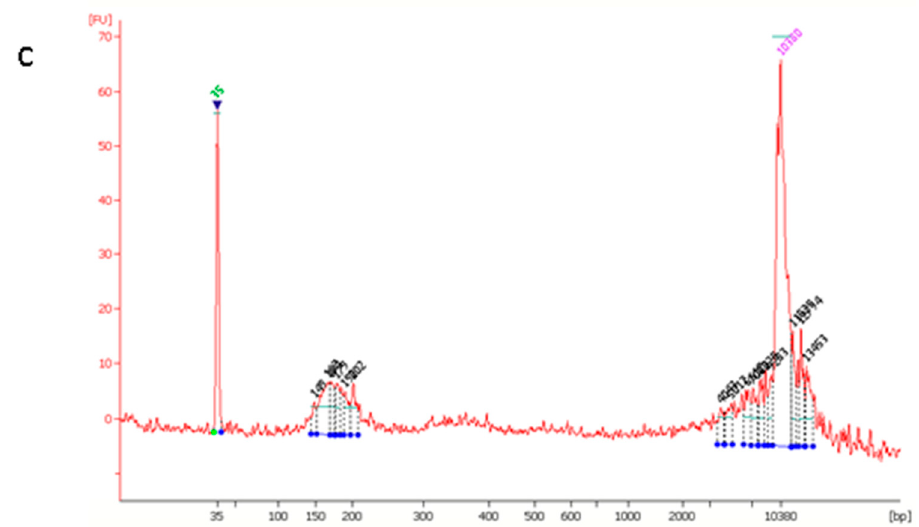
Figure 2. Electrophoregrams of pooled DNA sample from HF blood plasma NPCs ( a ) and individual DNA samples from BCP blood plasma NPCs ( b , c ). Data of Agilent 2100 Bioanalyser TM assay. Positions of 35 and 10,380 bp markers are shown with arrows.